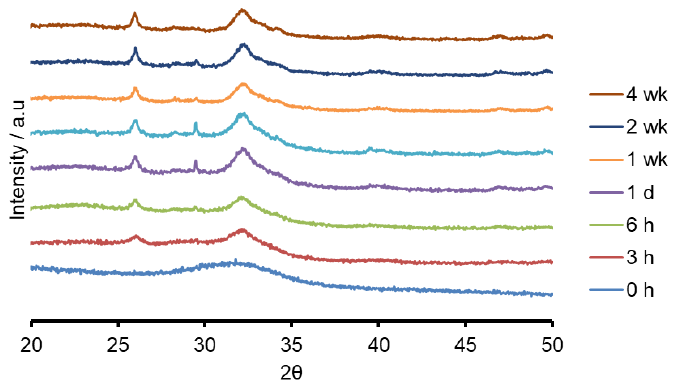
Figure 1. XRD patterns of Na-FBAG before and after immersion.